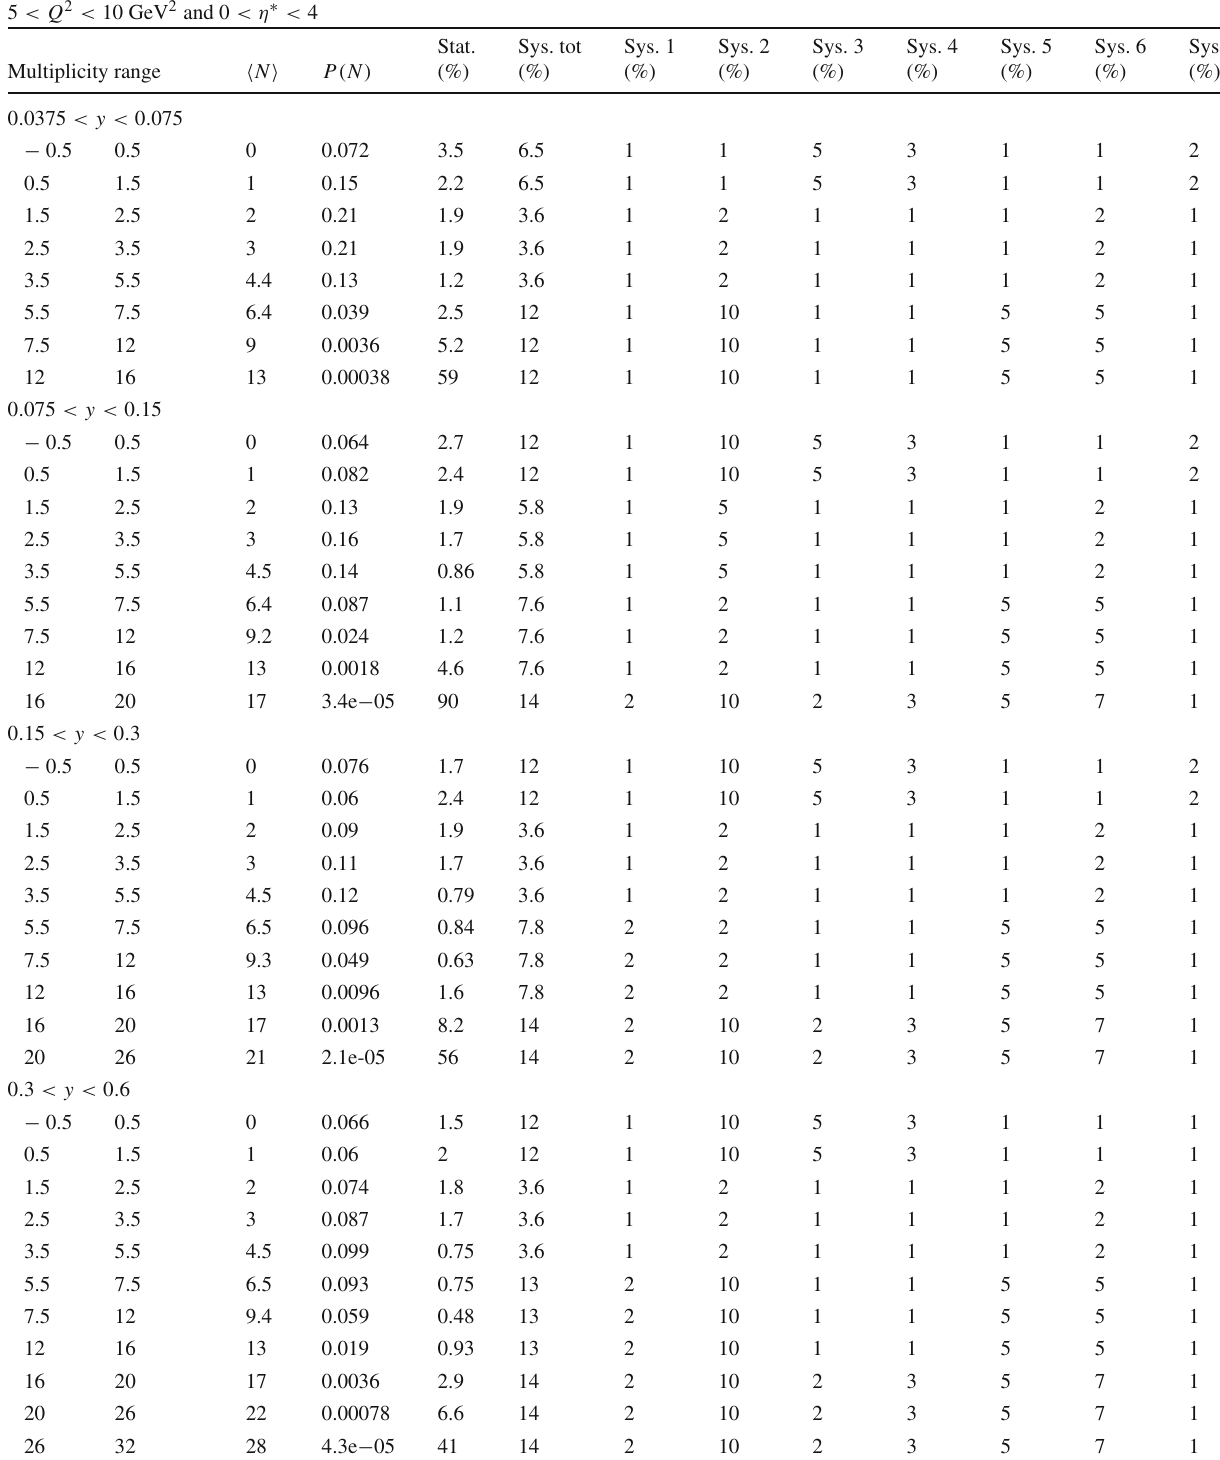
Table 25 Charged particle multiplicity distributions P ( N ) measured √ s = 319GeV with in the ranges of photon virtual- in ep DIS at ity 5 < Q 2 < 10 GeV 2 and charged particle pseudorapidity range Multiplicity distributions in DIS 5 < Q 2 < 10 GeV 2 and 0 < η ∗ <